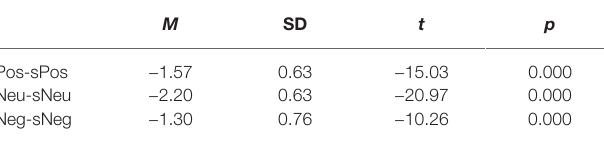
Pos, Neu, and Neg means the normative ratings of positive, neutral, negative pictures in CAPS, respectively; and sPos, sNeu, and sNeg means the rating of positive, neutral, and negative pictures judged by participants,